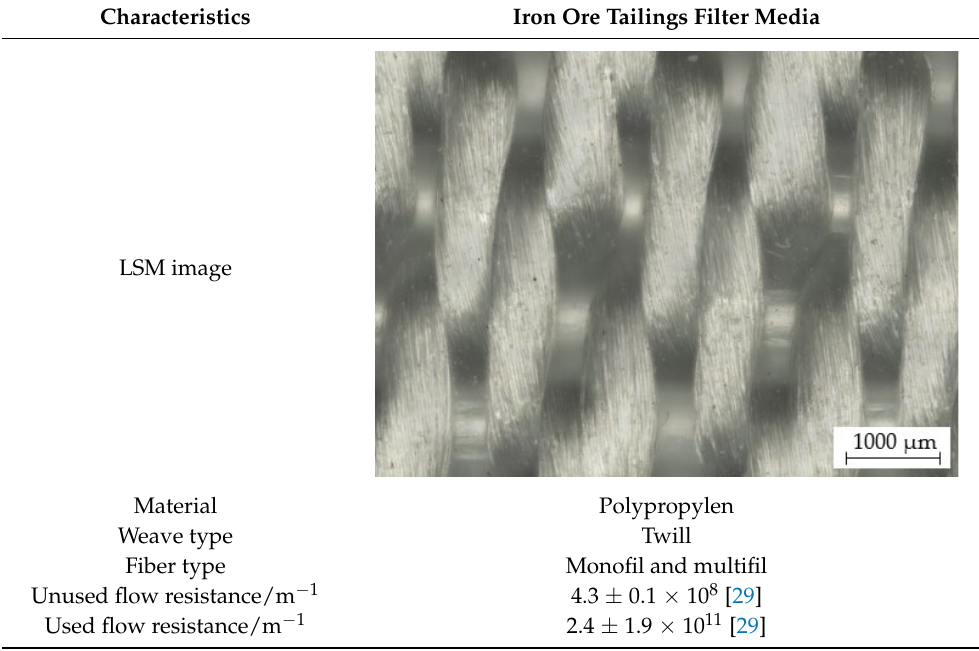
Table 2. Color image (10×) of the unused cloth state taken with an LSM and characteristics.